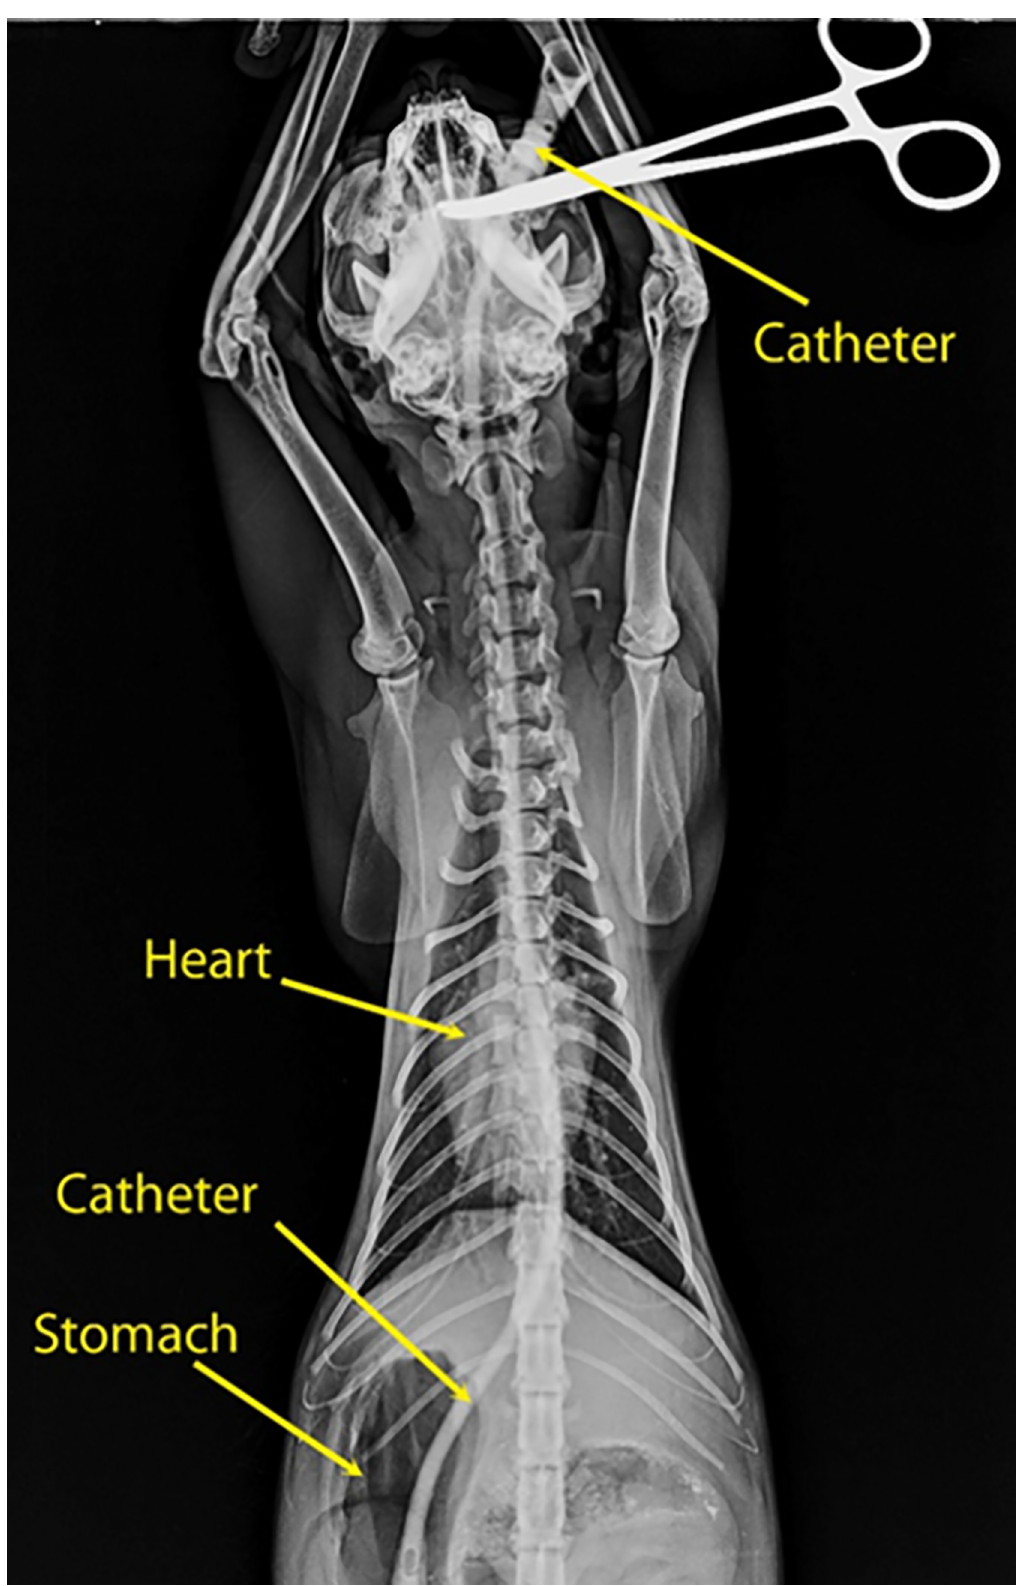
Fig 7. Ventro-dorsal view of a barium-filled catheter radiograph of a cat oesophagus, showing its anatomy. https://doi.org/10.1371/journal.pone.0233983.g007 PLOS ONE | https://doi.org/10.1371/journal.pone.0233983 June 2,